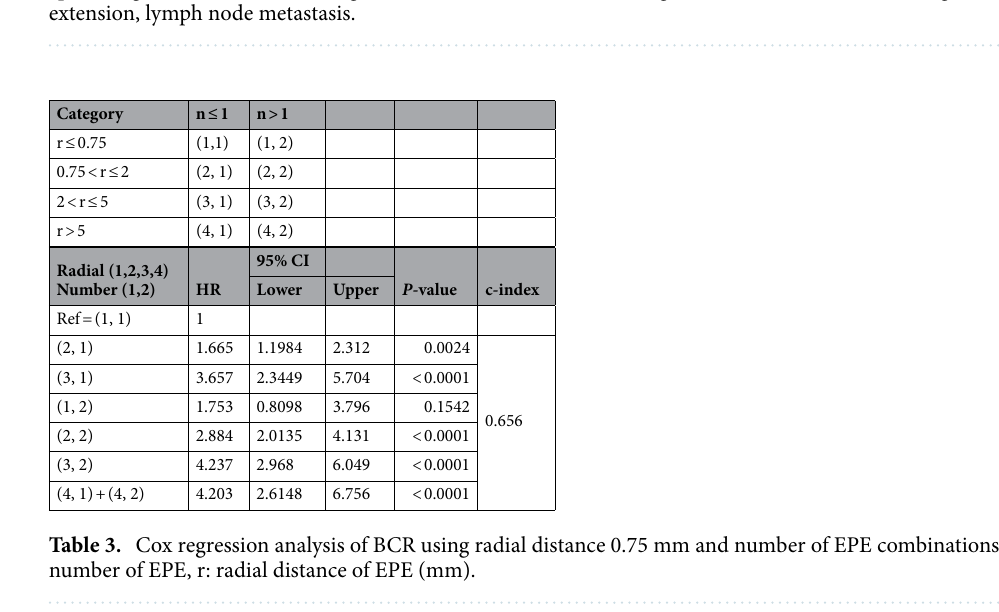
Table 2. Cox regression analysis of EPE parameters to affect pT3a prostate cancer patients’ survival. *Adjusted for age, initial PSA level, prostate grade group, tumor volume, perineural invasion, lymphovascular invasion,